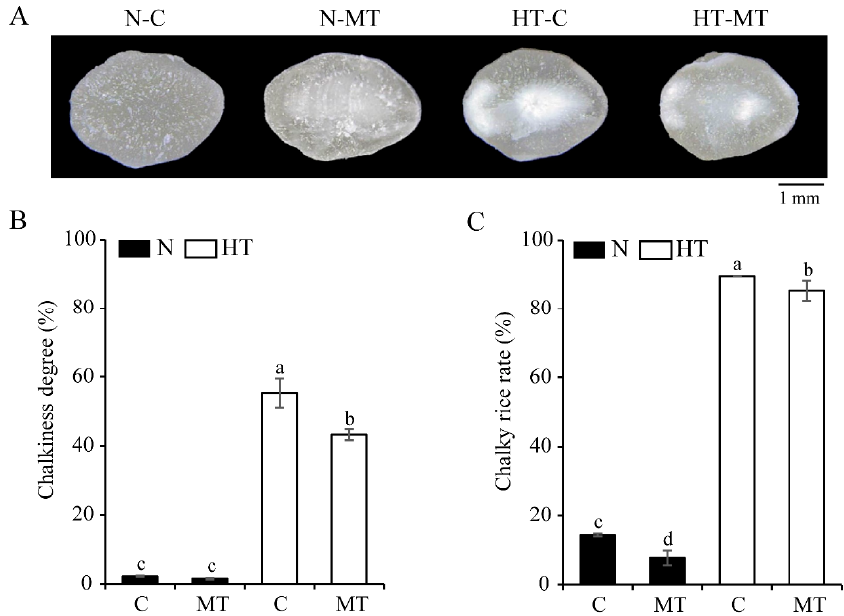
Figure 2. Effects of melatonin treatment on the appearance quality of NPB grain at different tem- peratures. ( A ) Photographic observation of cross sections of NPB grains with different treatments. ( B ) Chalkiness degrees of NPB grains with different treatments. ( C ) Chalky grain rate of NPB grains with different treatments. The data presented in the figure are repeated through three independent experiments, values with different letters (a, b, c and d) in the same column are significantly differ- ent at p < 0.05, calculated by one-way ANOVA. “N” and “HT” indicate normal and high tempera- ture conditions. “C” and “MT” indicate H 2 O and melatonin treatment, respectively.